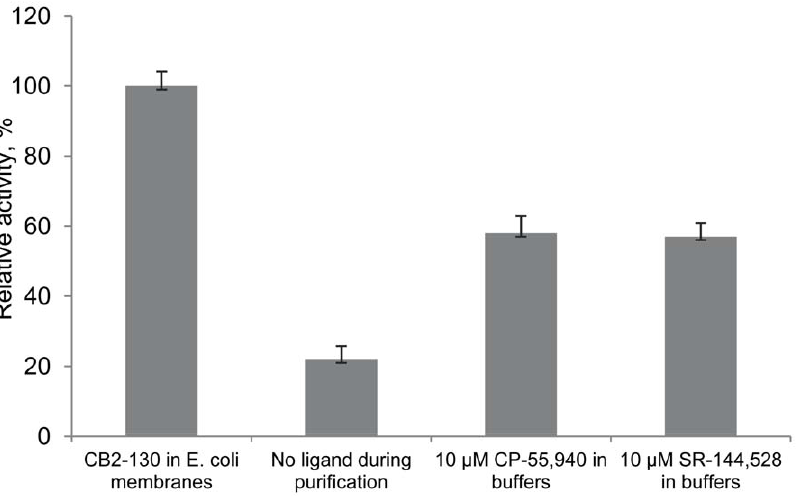
Figure 6. Stabilizing effects of cannabinoid ligands on CB 2 in detergent micelles. Ligands (CP-55,940 or SR-144,528) at concentration 10 m M were introduced into buffers either through an entire purification procedure or just prior to the reconstitution of the purified CB 2 into proteoliposomes as indicated. E. coli BL21(DE3) membranes expressing fusion CB 2 -130 were used as an activity standard. A quantity of 2 m g of E. coli membranes expressing